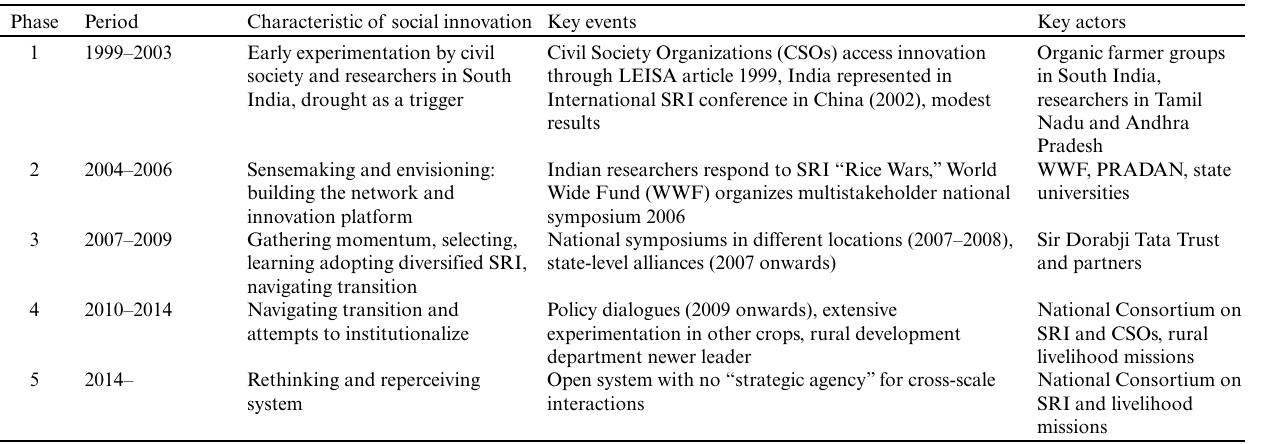
Table 1 . Complex evolution of System of Rice Intensification (SRI) in India